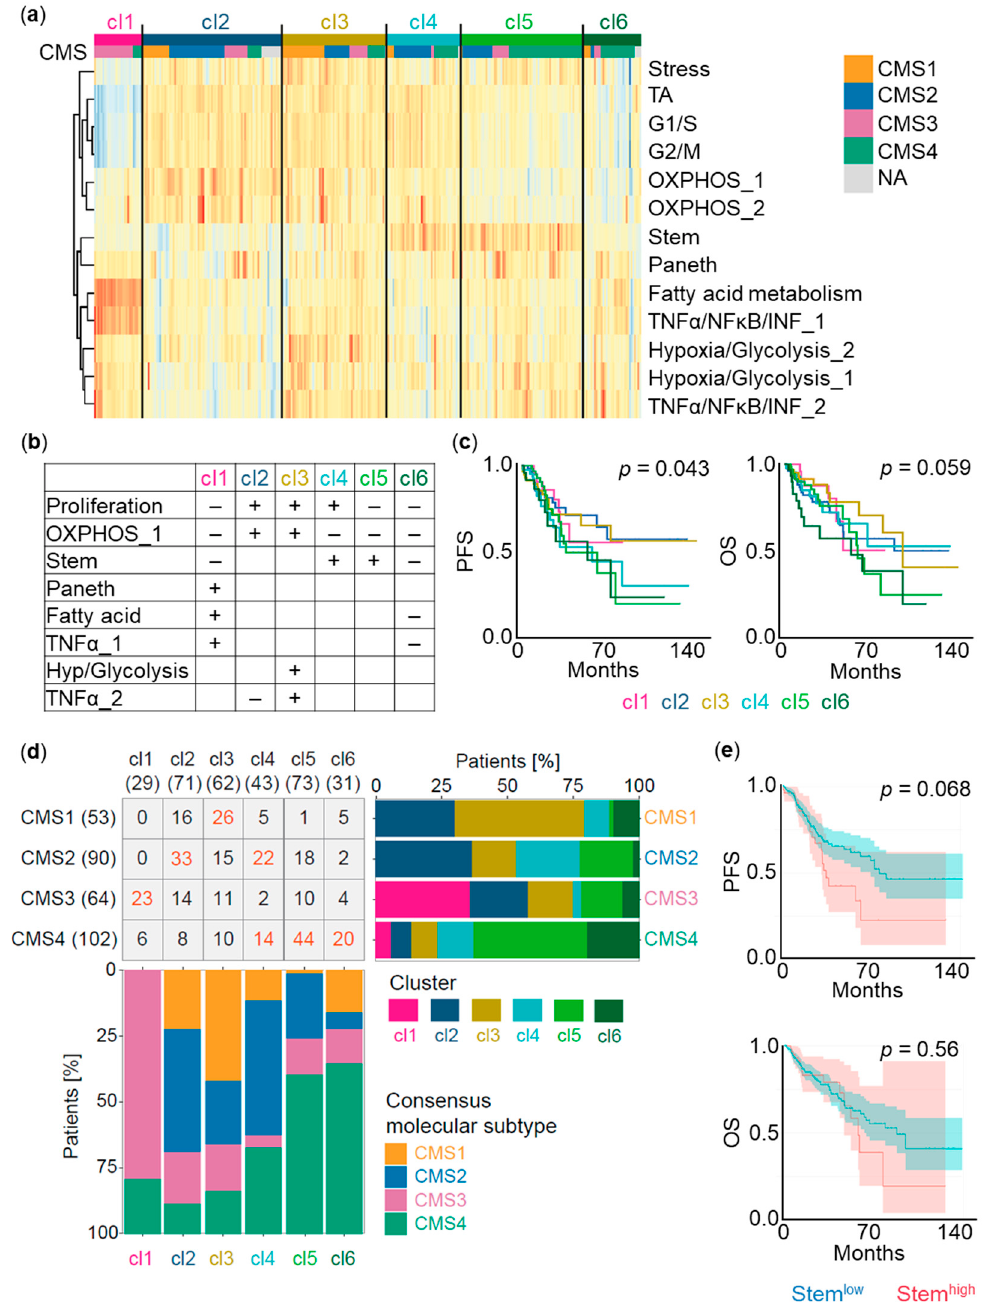
Figure 2. Analysis of single-cell RNA-sequencing (scRNA-seq) signature expression in The Cancer Genome Atlas (TCGA) colon adenocarcinoma (COAD) cohort. ( a ) Heatmap reflecting signature expression in the identified clusters of patients (cl1–cl6). Rows correspond to scRNA-seq signatures ( n = 13). Columns correspond to TCGA COAD samples ( n = 328). Clusters are further classified according to consensus molecular subtypes (CMS1–CMS4). NA, not assigned; OXPHOS, oxidative phosphorylation; TA, transit-amplifying. ( b ) Cell type and cell state signature expression levels defining cl1–cl6. Hyp, hypoxia. ( c ) Kaplan–Meier survival curves displaying progression-free survival (PFS) and overall survival (OS) for cl1–cl6. p -Values of the comparison cl6 + cl5 + cl4 versus cl3 + cl2 + cl1 for PFS and cl6 + cl5 versus cl4 + cl3 + cl2 + cl1 for OS. ( d ) Representation of CMS1–CMS4 within cl1–cl6 and of cl1–cl6 within CMS1–CMS4. Numbers indicate amount of patients classified under individual categories. Numbers marked in red highlight dominant combinations. Patients not assigned to a CMS ( n = 19 patients) were excluded. ( e ) PFS and OS of TCGA COAD patients with high versus low expression of the stem signature. Shaded areas indicate 95% confidence